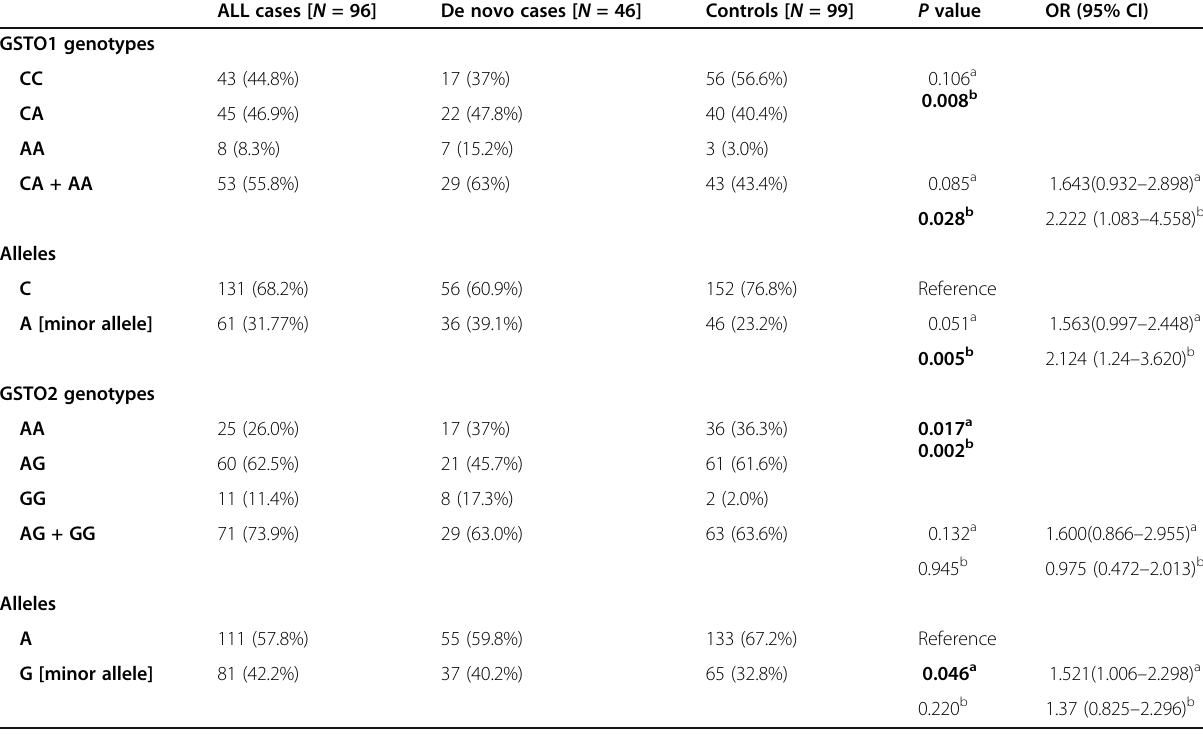
Table 3 GSTO1*A140D and GSTO*2N142D genotypes and allele distribution in the ALL cases, de novo ALL cases, and control groups